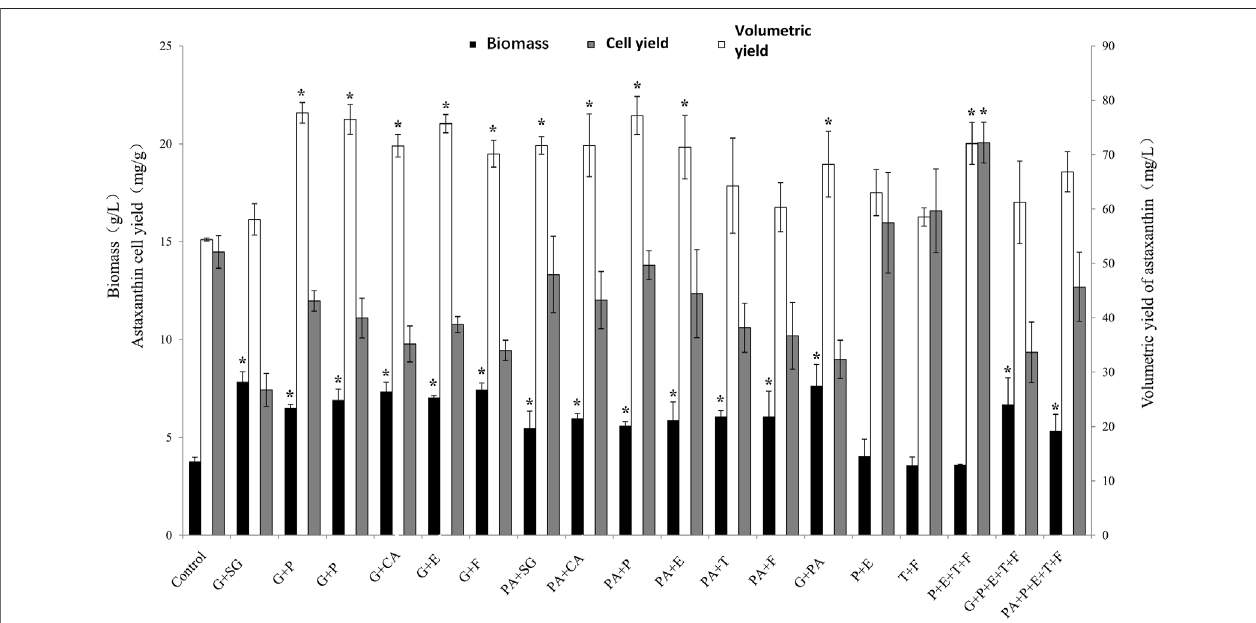
FIGURE 3 | The effect of different regulator combinations on biomass, astaxanthin cell yield and volumetric yield in P. rhodozyma MVP14. The abbreviation of abscissa in the fi gure is the following meaning, G: Glutamic acid, SG: Sodium gluconate, CA: Citric acid, P: Penicillin, E: ethanol, T: Triclosan, F: Fluconazol, PA: Pyruvic acid. (* signi fi cantly different from control, p <